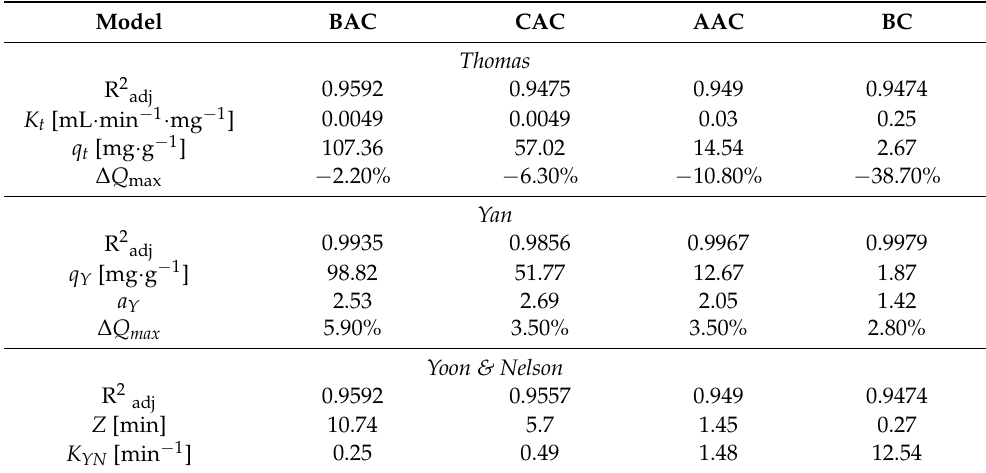
Table 6. Parameters of the fixed bed adsorption models used in this study and respective determina- tion coefficients for the four adsorbents. Model BAC